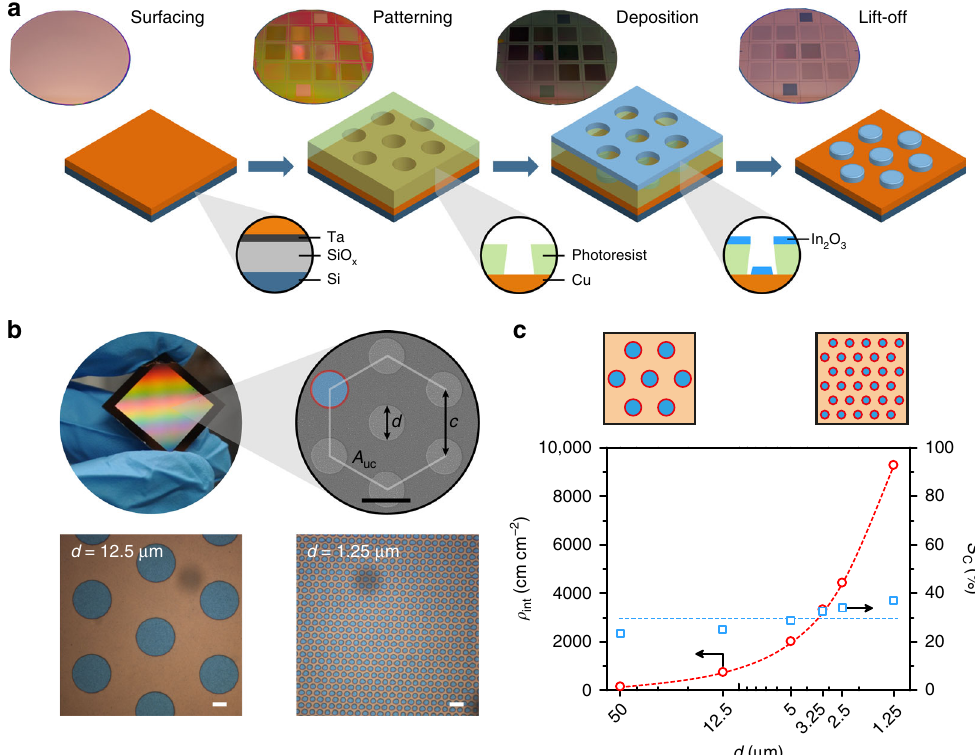
Fig. 1 Microfabrication and geometry of the structured electrodes. a Scheme of the microfabrication of the structured electrodes (In 2 O 3 /Cu shown) with an image of the wafer at each main step: creation of a Cu surface on a Si wafer by sputtering (the underlying SiO x and Ta layers act as electrical and diffusion barriers, respectively), patterning of the sacri fi cial photoresist layer, deposition of In 2 O 3 by electron beam evaporation, and lift-off of the photoresist. b Image of an individual structured electrode (In 2 O 3 /Cu, size 2 cm × 2 cm including edges, geometric active area A total = 2.25 cm 2 ) and a SEM micrograph showing the distribution of the islands on the surface with a hexagonal unit cell with area A uc . The geometry of the arrangement is de fi ned by the diameter of the islands ( d ) and the pitch ( c ). One of the islands and its interfacial perimeter are highlighted in blue and red, respectively. Optical micrographs show the size differences of the islands of two In 2 O 3 /Cu electrodes. Scale bars: 5 μ m. c Actual interfacial density ( ρ int ) and fraction of the electrode surface ( S C ) covered by In 2 O 3 (or In), measured by optical microscopy after the microfabrication of the model electrodes, as a function of the nominal island diameter ( d ). Trendlines are added as a visual